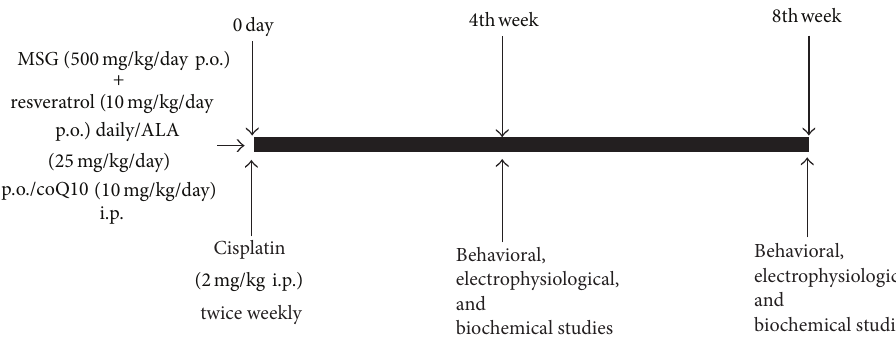
Figure 1: Schematic representation of experimental